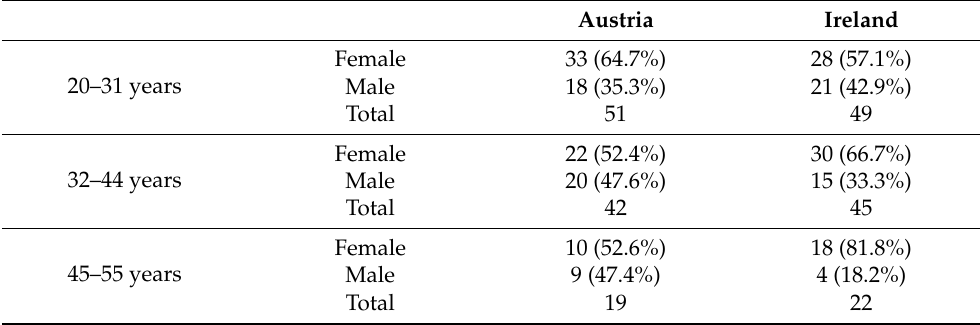
Table 1. Fulfilment of the quotas according to age and